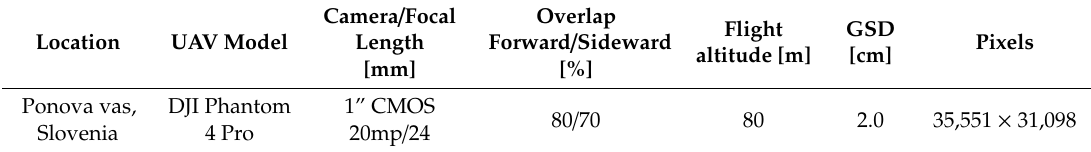
Table 1. Specification of unmanned aerial vehicle (UAV) dataset for the selected study area in